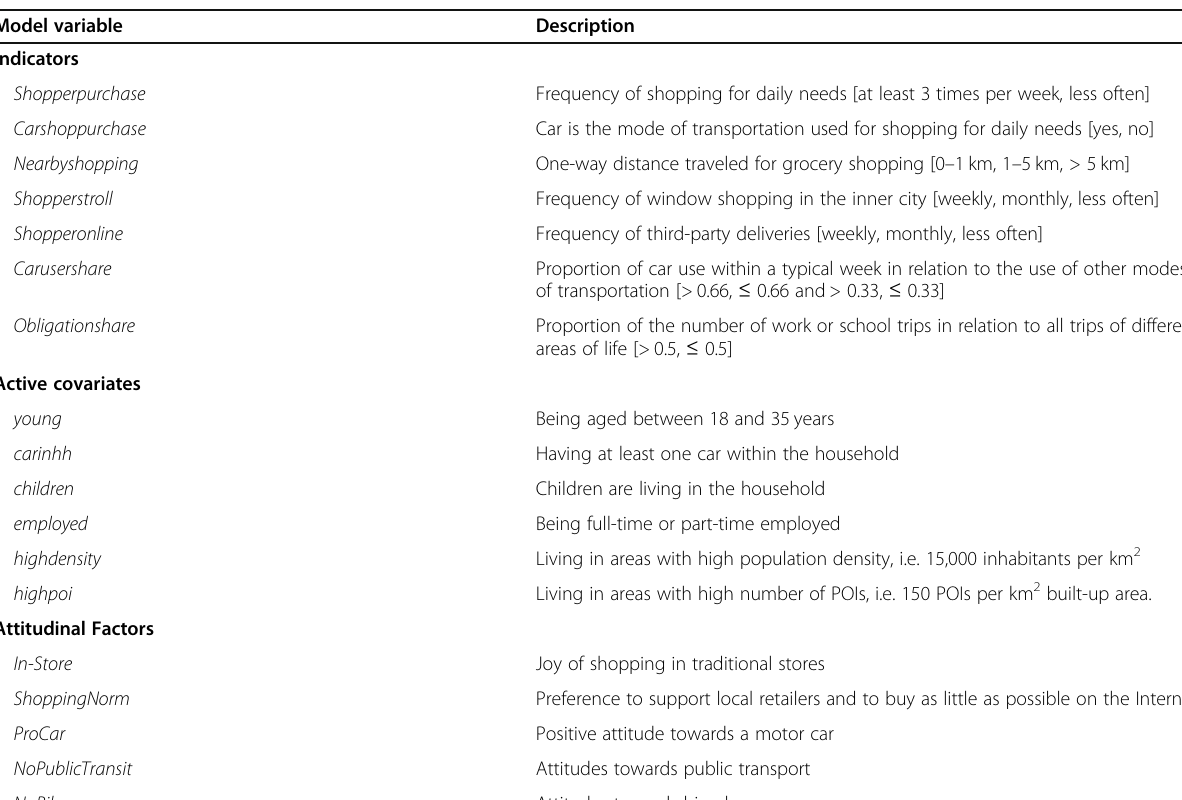
Table 1 Overview of the variables used in the model Model